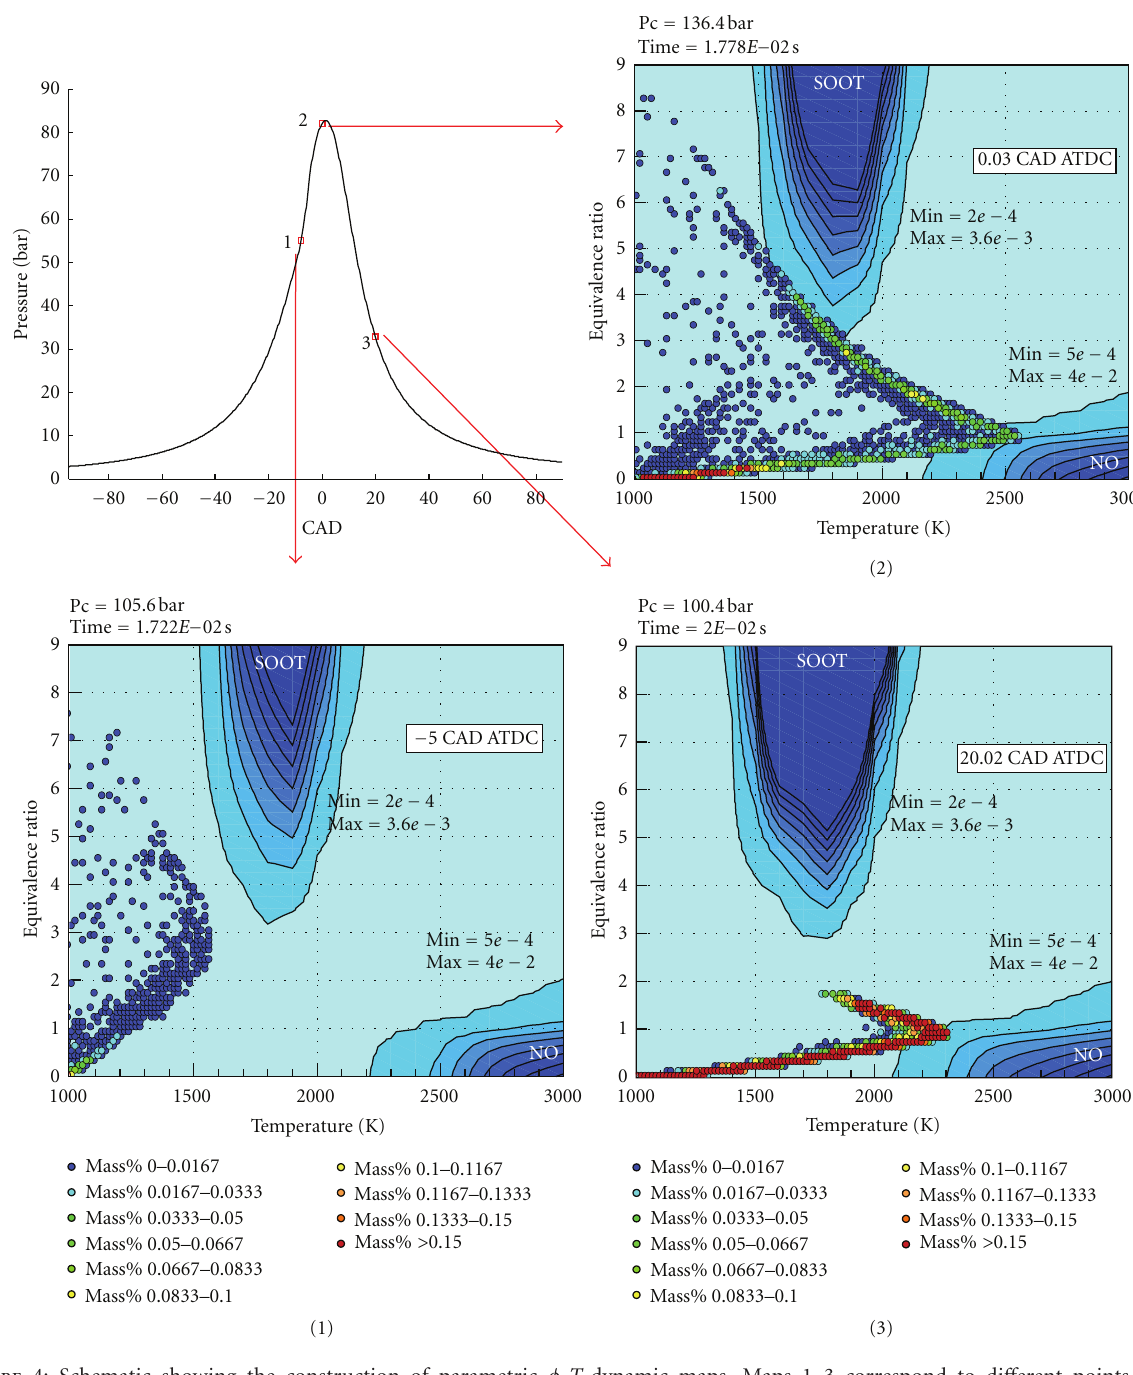
Figure 4: Schematic showing the construction of parametric φ - T dynamic maps. Maps 1–3 correspond to di ff erent points on the compression/expansion pressure